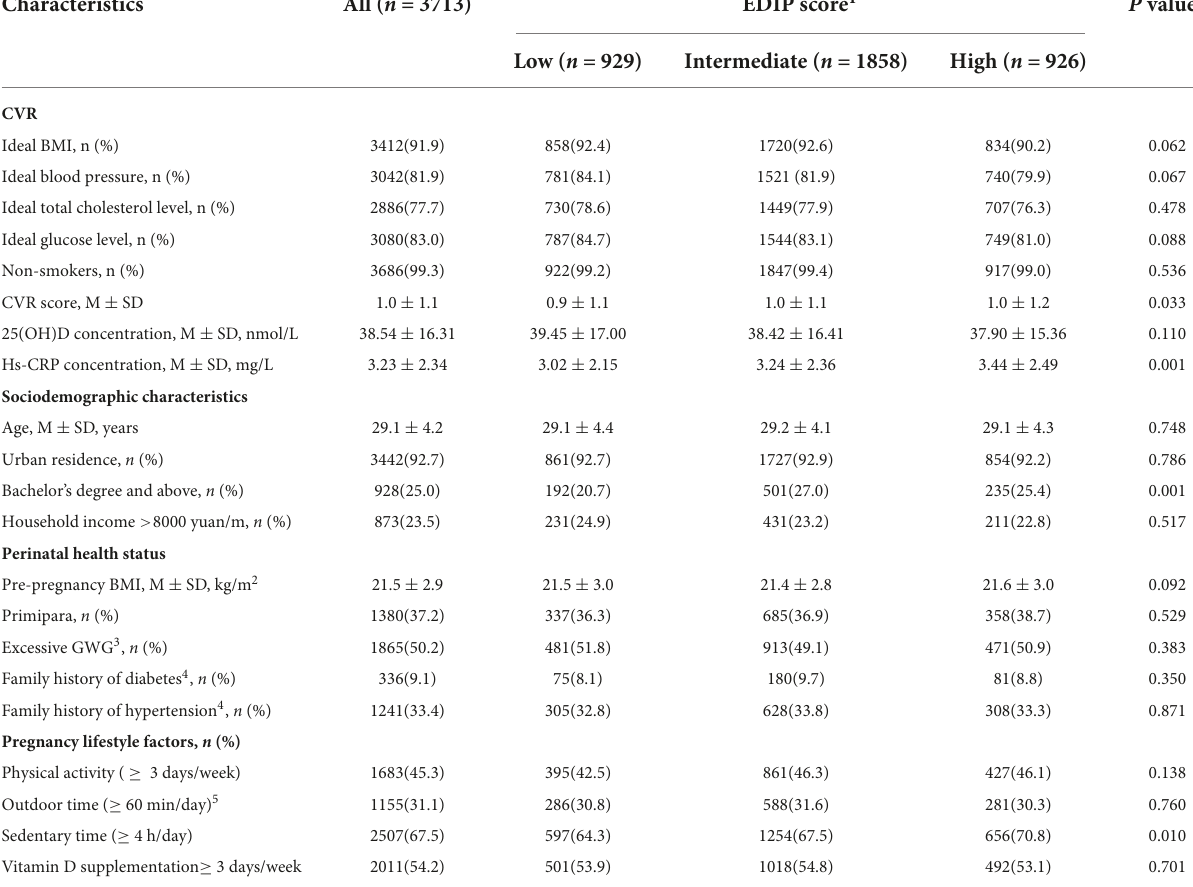
TABLE 1 Characteristics of the study